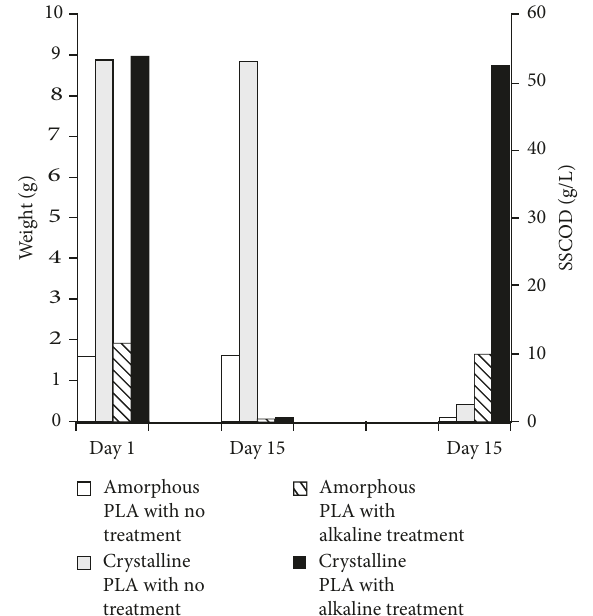
Figure 2: Weight of alkaline pretreated and untreated PLA at day 1 and day 15 (left) compared to SSCOD at day 15 (right).